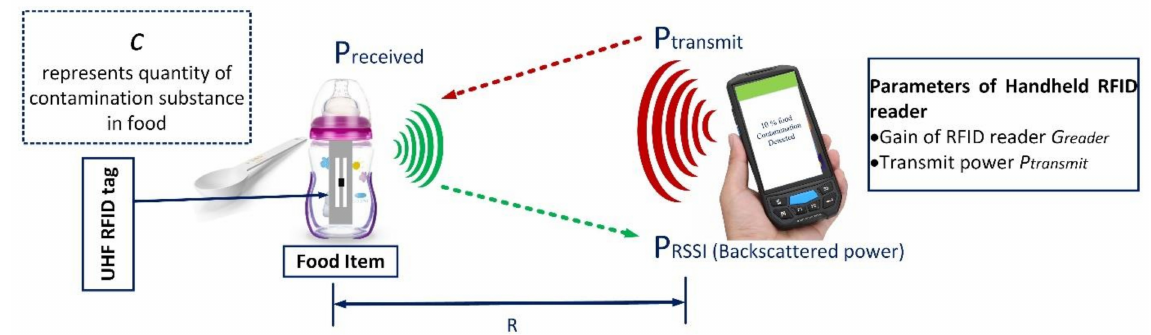
Figure 2. Methodology for food contamination sensing using UHF RFID